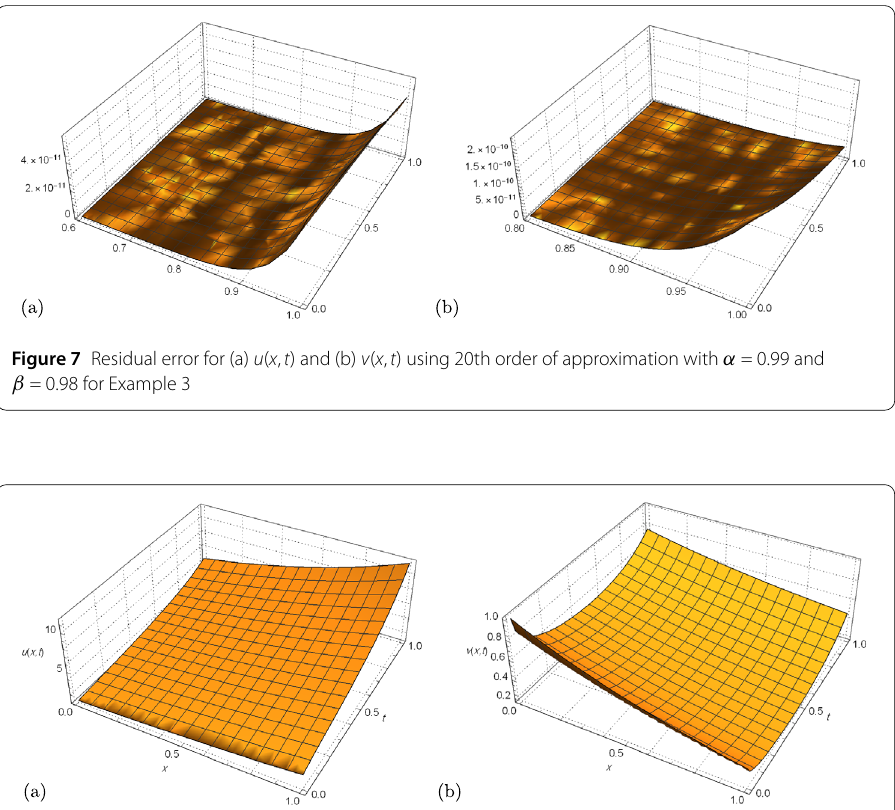
Figure 8 Solution of Example 3 for α = 0.7, β = 0.5, (a) for u ( x , t ) and (b) for v ( x , t )